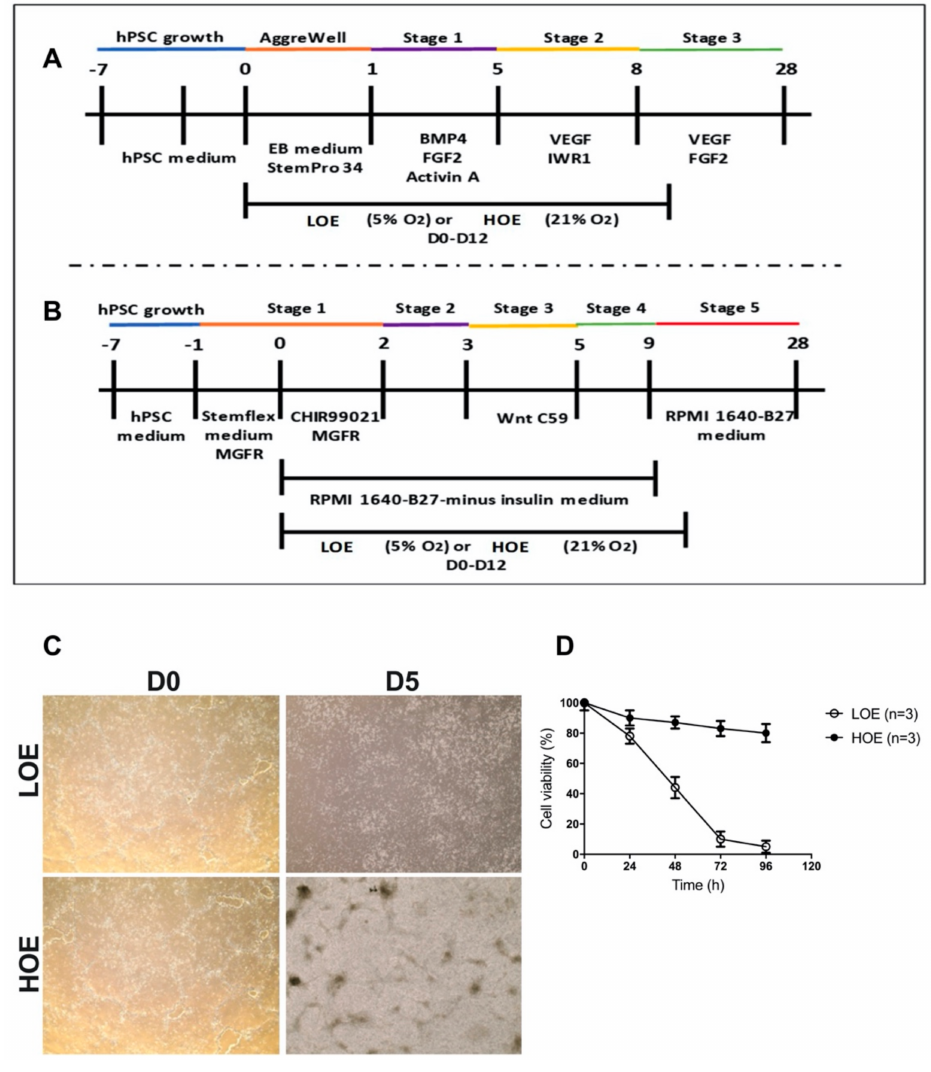
Figure 1. Timeline of the differentiation protocols of hPSCs. ( A ) 3D-based protocol for the formation of cardiac spheroids using AggreWell plates. ( B ) 2D-based protocol for the monolayer formation via the sandwich-based protocol. ( C ) Images illustrating the state of the hPSC at day 0 and 5 upon cardiac differentiation via 2D monolayer protocol under LOE and HOE. The acquisition was performed using EVOS XL Core Imaging System microscopy (magnification x4). ( D ) Cell viability in 2D cardiac monolayer (using hiPSC UB47 line) differentiated in LOE (white dot plots) and HOE (black dot plots) conditions. The number of experiments is 3 independent biological replicates. Data are shown as mean ± SEM. Significance was calculated by 2-way ANOVA, Bonferroni’s multiple